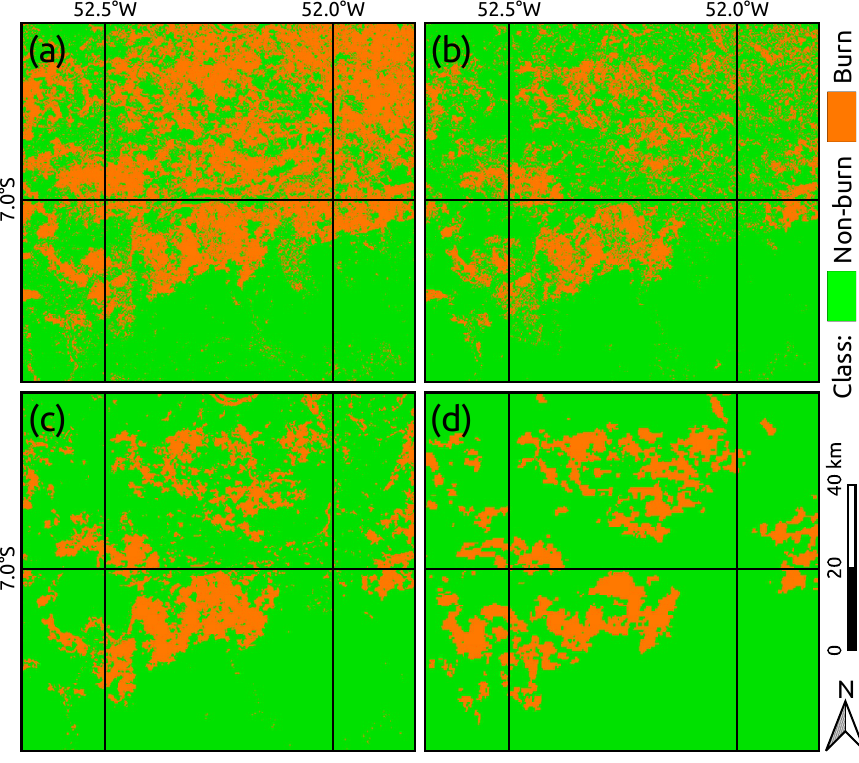
Figure 10. The mapping of fire-affected locations provided by the ( a ) MTDNBR, ( b ) GKM, and ( c ) UFD+MRF methods for Area 1 using OLI data. Estimates from the MBA product are shown in ( d ). Representations comprise the analyzed period of 1 August to 31 October